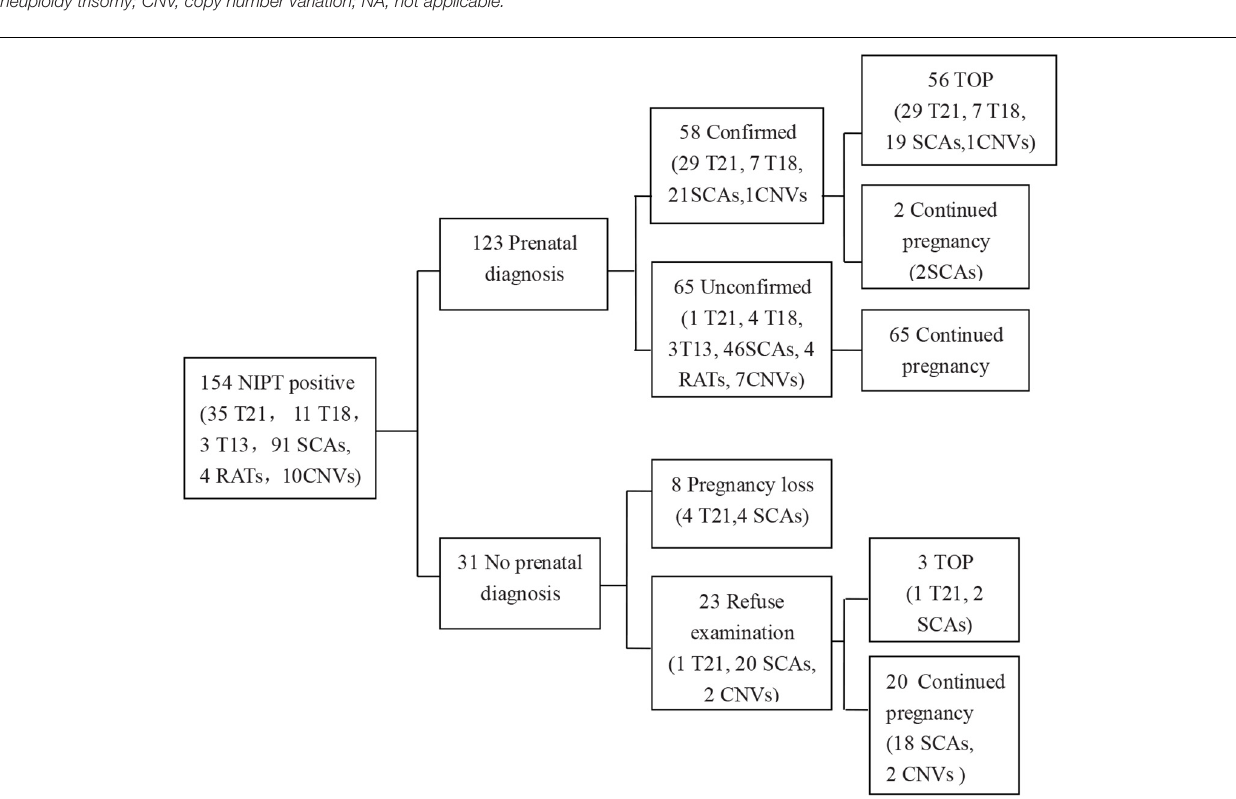
TOP because of an abnormal fetal ultrasound result and one missed